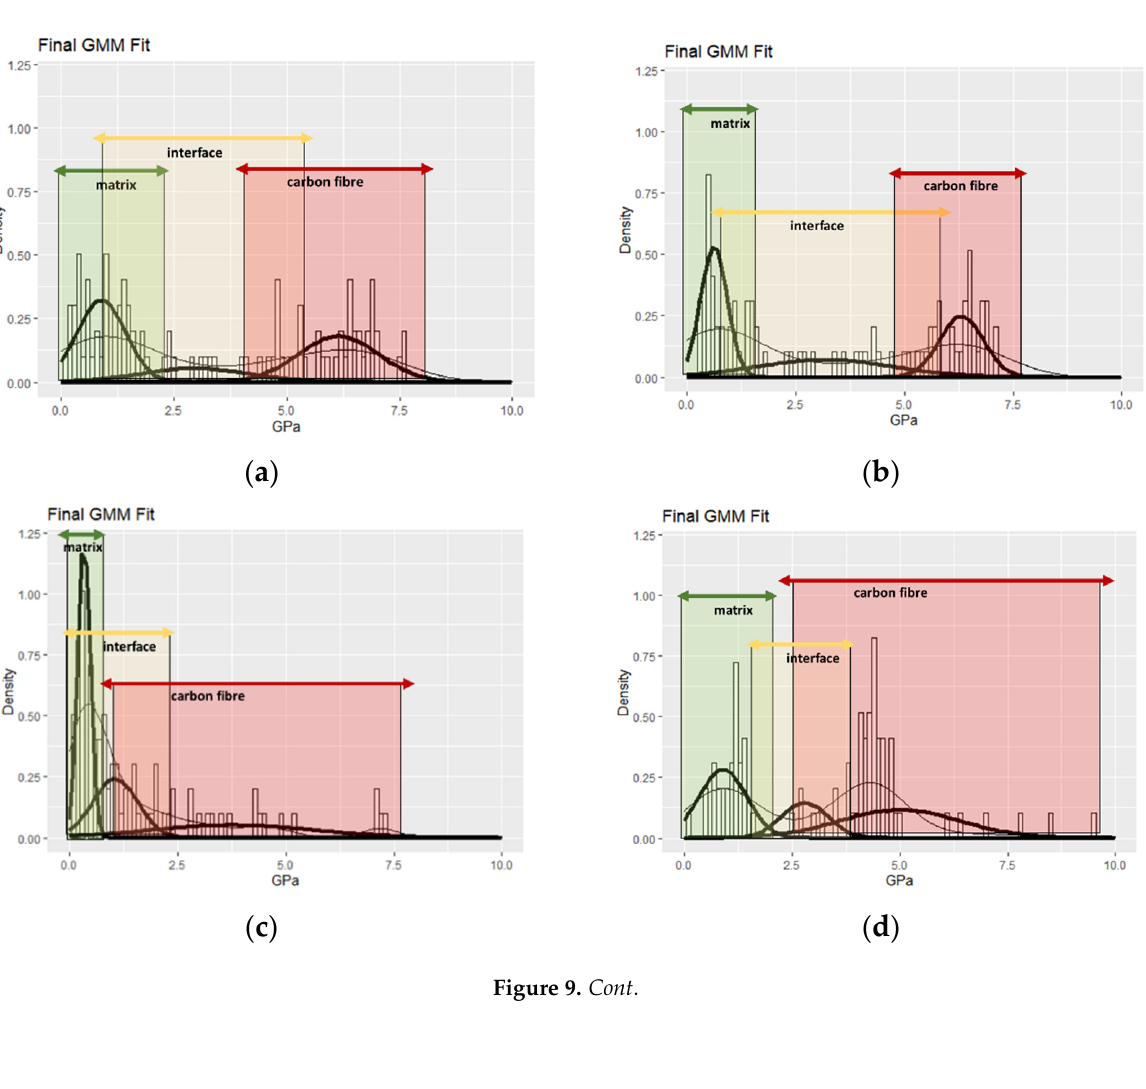
Figure 8. SEM fracture analysis: ( a ) Untreated fabric CFRP ( b ) PMAA-treated fabric CFRP ( c ) APP- treated fabric CFRP ( d ) Epoxy resin bonded on CF after APP treatment.